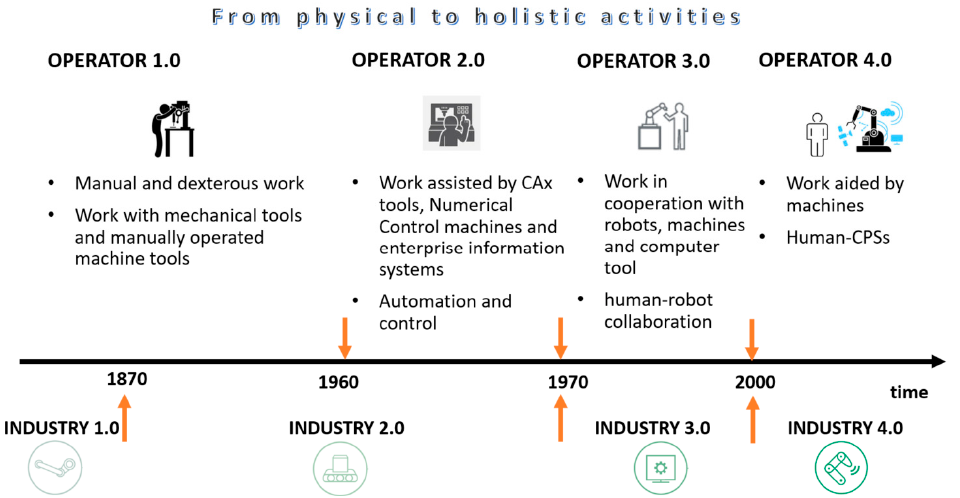
Figure 25. ( R)Evolution of the Operator Concept Generation. Source: own contribution based on Figure 25. (R) Evolution of the Operator Concept Generation. Source: own contribution based [45,139,140]. on